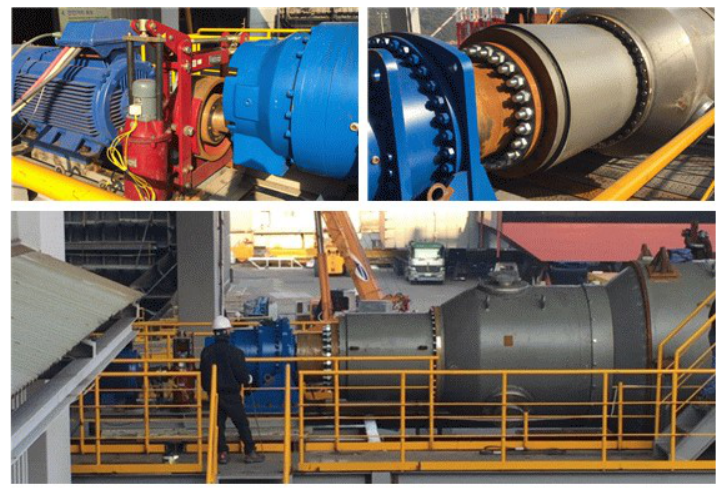
Figure 9. Dynamo test pictures for PMSG and Drivetrain of 200 kW TEC.